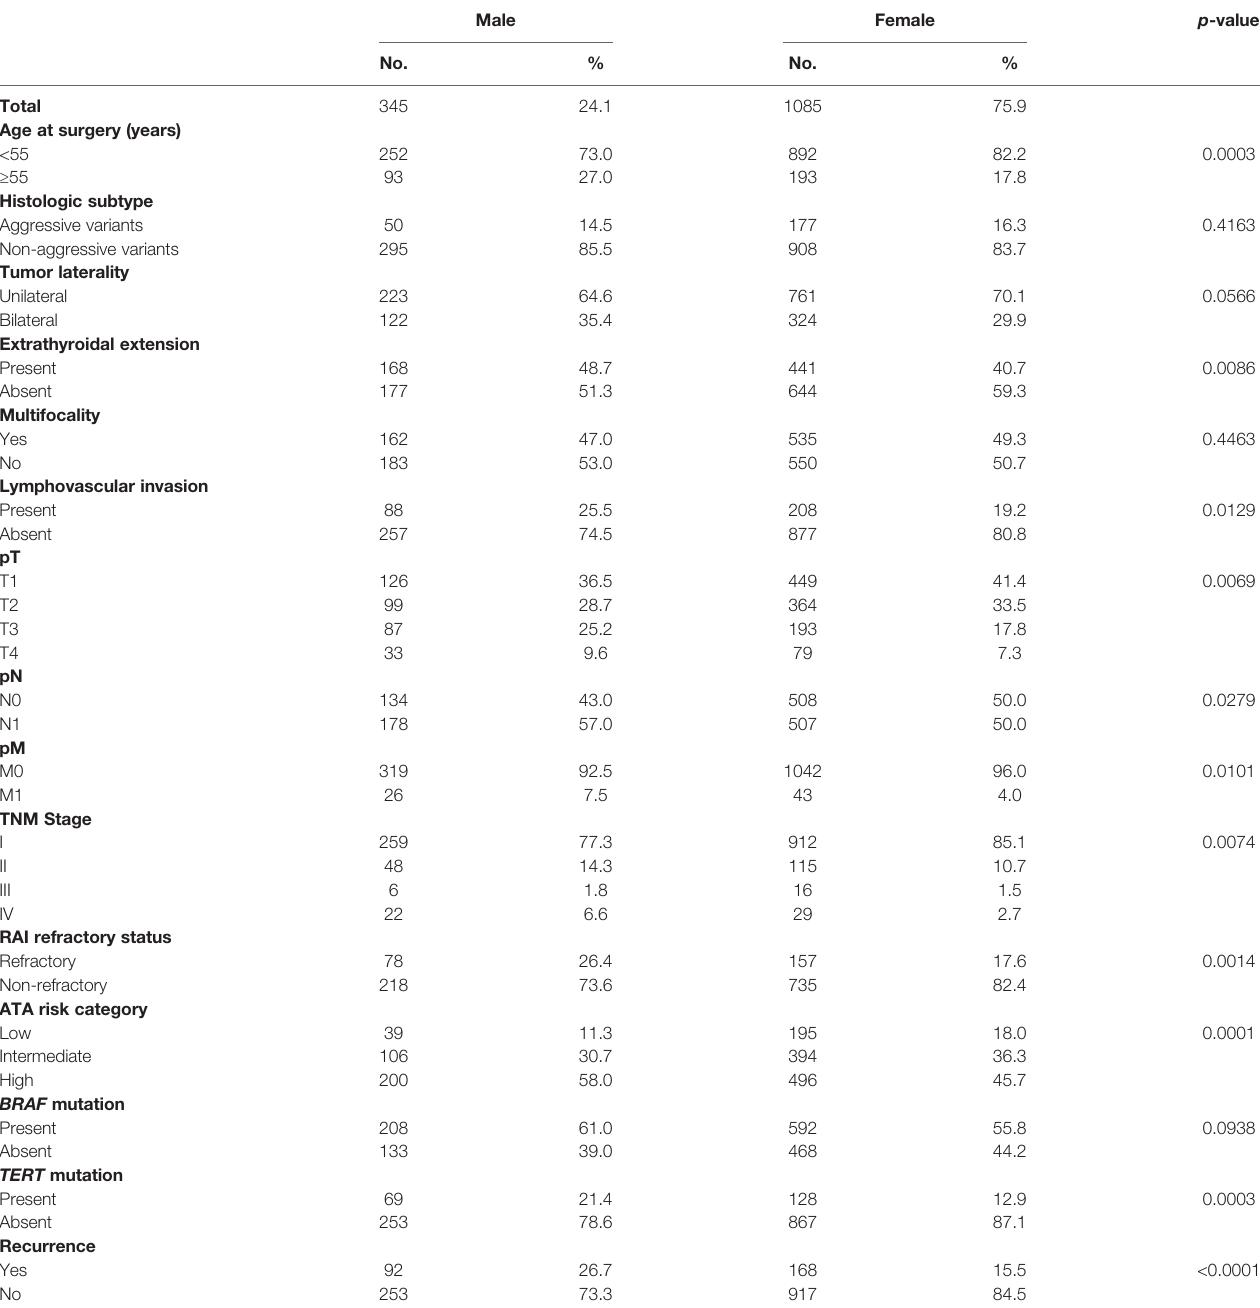
TABLE 2 | Clinico-pathological associations of gender in papillary thyroid carcinoma.